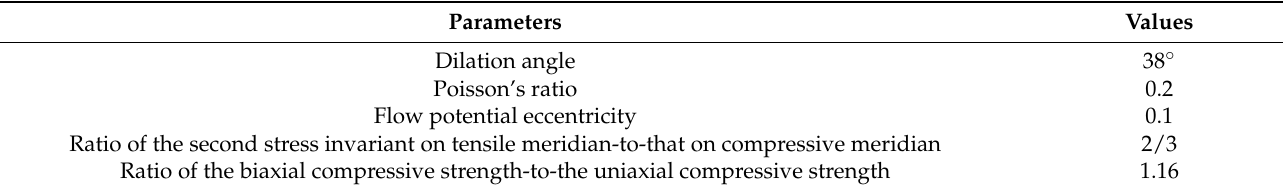
into Equations (7) and (8), the D c ( D t )- ε t,in ( ε c,in ) relationship could be obtained. The tension